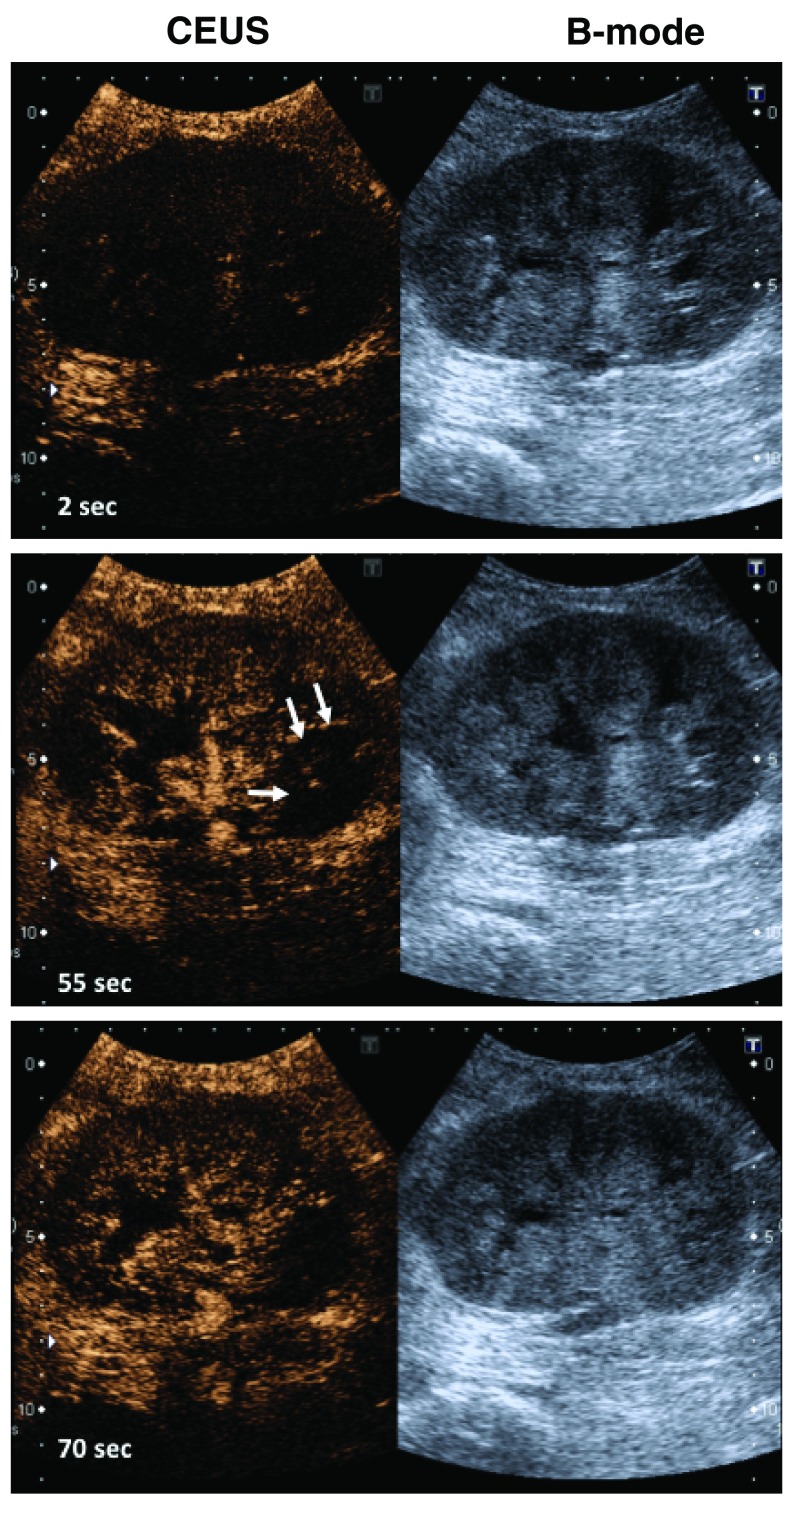
Contrast enhanced ultrasound (CEUS) and B-mode ultrasound of kidney allograft with acute rejection.The left panel shows the enrichment of the microbubbles within seconds in the renal vessels of the allograft of a patient with severe rejection. Areas in the lower pole of the kidney are hypoperfused after microbubble injection, indicating less blood flow to this region (arrows). The right panel corresponds to the B-mode ultrasound. These images are original, unpublished data (F. Gueler).